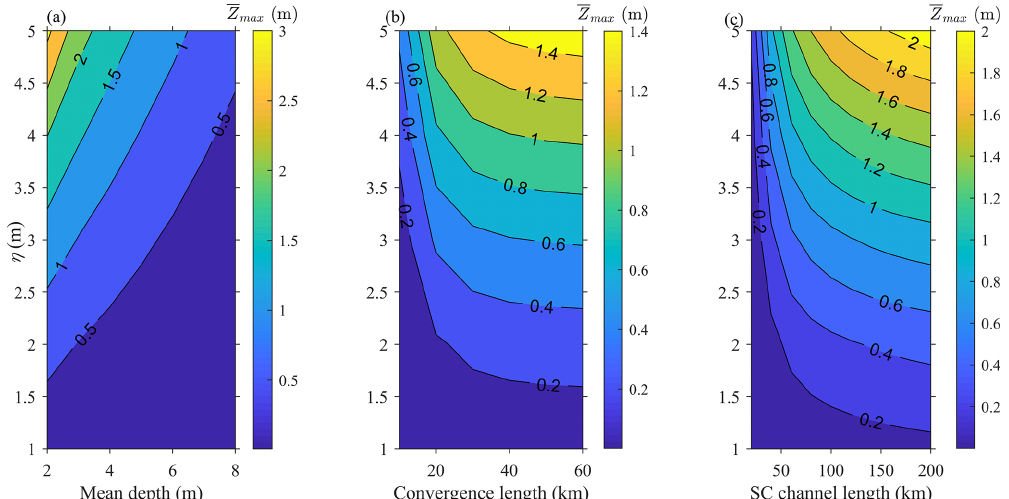
Figure 10. Maximum tidally averaged water level ( Z max ) as a function of the tidal forcing and mean depth (a) , convergence length (b) , and estuary length (c) at a semi-closed channel.